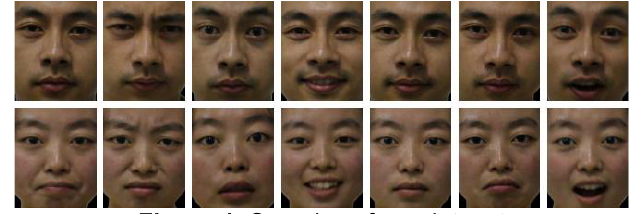
Figure 1. Samples of our